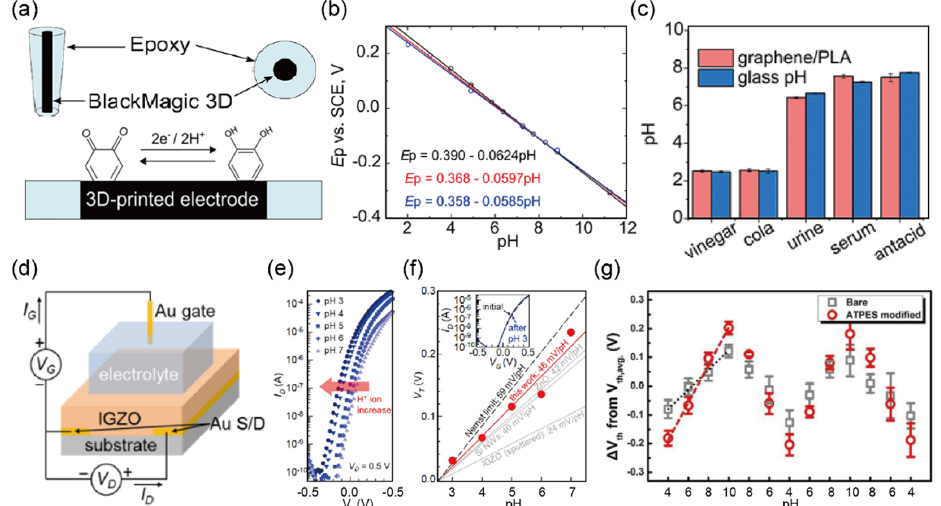
Figure 3. Selective detection of hydrogen ion ( a ) Schematic diagram of the 3D-printed electrode geometry and redox reaction of quinone groups on the electrode surface. ( b ) The relationship between pH and the reduction peak potential of three independent electrodes for the pH range from 2.02 to 11.22 with linearity (R 2 ≥ 0.99 for all sensors). ( c ) Bar graph comparing the pH detection results obtained by the graphene/polylactic acid (G/PLA) sensor and a conventional glass pH probe in unadulterated real samples, including vinegar, cola, urine, serum, and antacid (reprinted with permission from [32]; copyright 2017 ACS). ( d ) Schematic the indium–gallium–zinc–oxide electro ‐ lyte ‐ gated thin ‐ film transistors (IGZO ‐ EGTFTs) structure. ( e ) Transfer characteristics of the IGZO ‐ EGTFTs with varying values of pH. As the pH decreased from 7 to 3, the threshold ‐ voltage (V TH ) shifted in a negative direction. ( f ) Sensitivity analysis based on the V TH shift of IGZO ‐ EGTFTs, in ‐ cluding a slope comparison with the Nernst limit and other technologies. Inset: transfer curves at pH 7 before and after exposure to the pH 3 solution (V D = 0.5 V) (reprinted with permission from [33]; copyright 2021 IEEE Xplore). ( g ) Response of V TH shifts of IGZO ‐ EGFETs with and without amino ‐ silanization exposed to varying pH levels (reprinted with permission from Ref. [34]; copy ‐ right 2018 Elsevier).